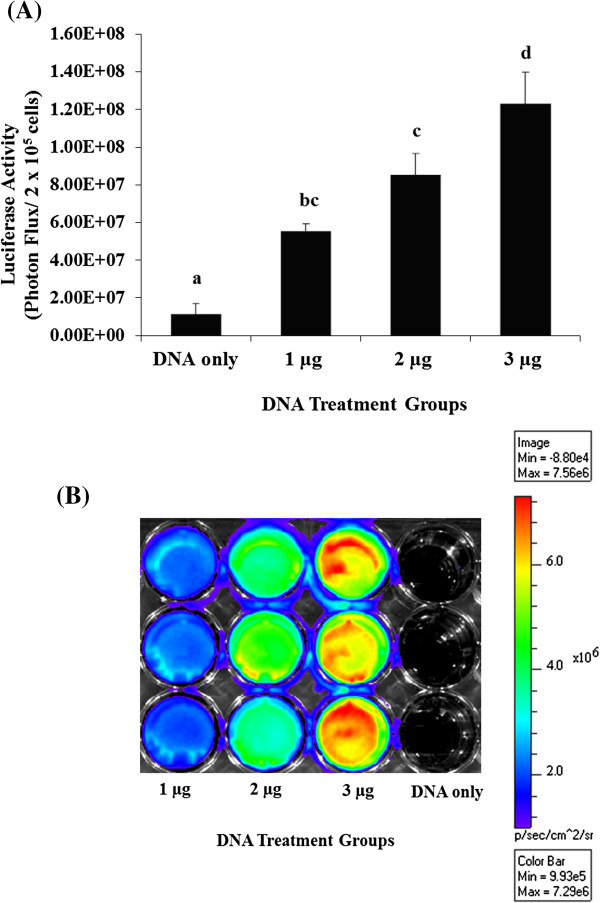
Luciferase activities in isolated granulosa cells from intact follicles in DNA only, 1 μg, 2 μg, and 3 μg groups. To demonstrate luciferase activity in follicular granulosa cells, luciferase activity of isolated granulosa cells (2 × 105 cells per well) from intact follicles in the DNA only (n = 9), 1 μg (n = 8), 2 μg (n = 8), and 3 μg (n = 7) groups were quantified using standard luciferase assay (Bright-Glo) in lysed cells (A). The data were expressed as mean ± SEM of Luciferase Activity (Photons Flux/2 × 105 cells). Values with different superscripts in a group are significantly different (P < 0.05).Luminescence imaging of luciferase activity with medium binning in a 24-well plate format (B). The scale bar on the right shows pseudocolor display for the photon flux of the luciferase with red and blue representing highest and lowest values, respectively. The gray scale photographic image and bioluminescence color image were superimposed.